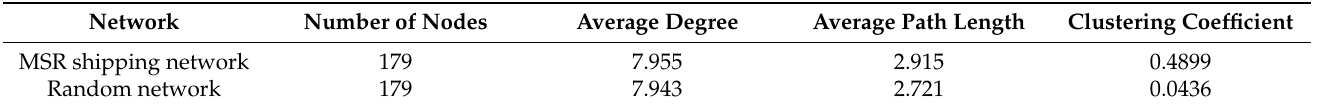
Table 2. Topological comparison between the MSR shipping network and a random network of the same scale.